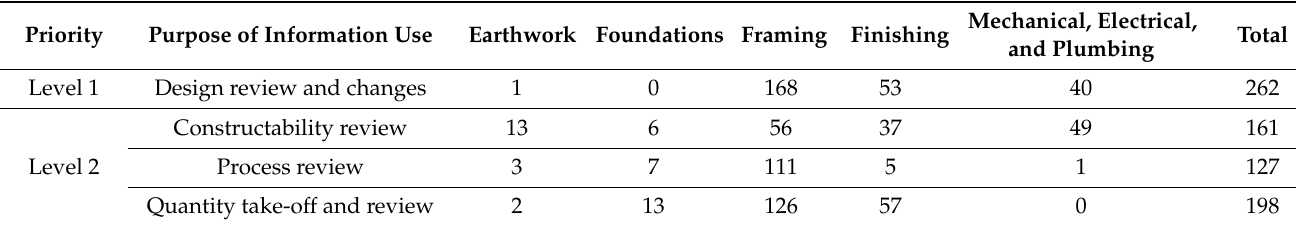
Table 4. Classification of priority by purpose of information